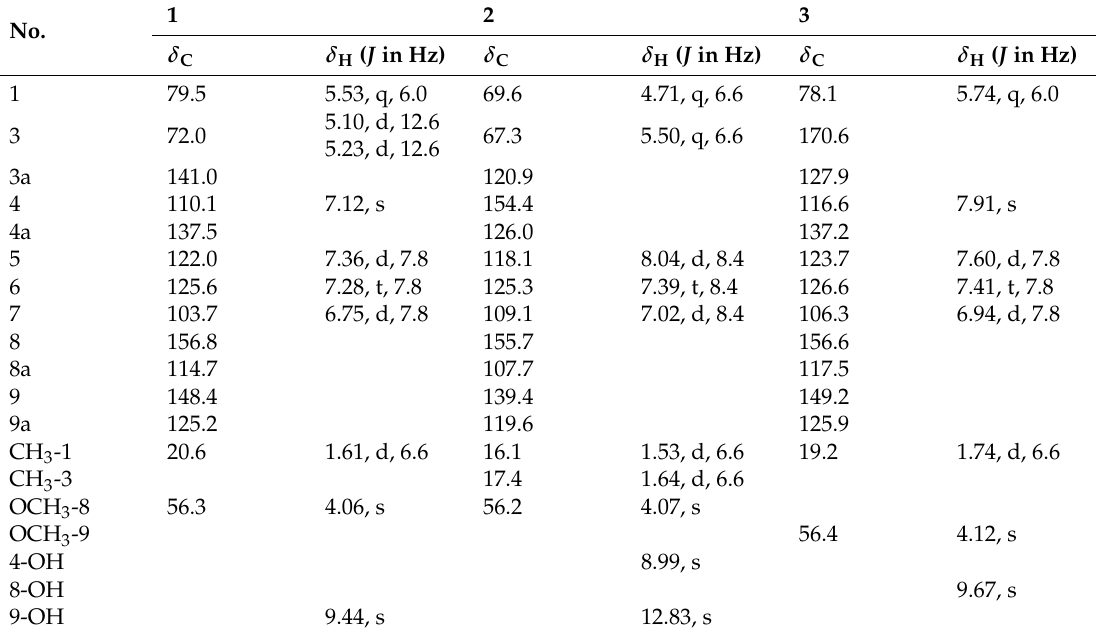
Table 1. 1 H (600 MHz) and 13 C-NMR (150 MHz) assignments of compounds 1 – 3 (CDCl 3